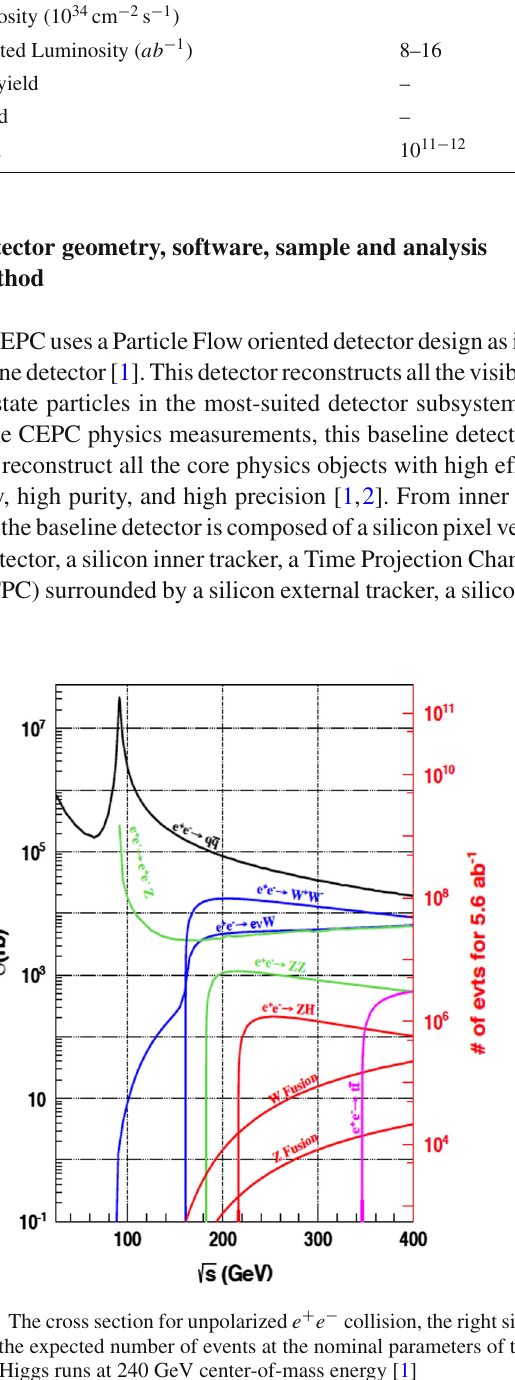
Table1 Runningtime,instantaneousandintegratedluminositiesatdif- ferent values of the center-of-mass energy and anticipated correspond- ing boson yields at the CEPC. The Z boson yields of the Higgs factory and WW threshold scan operation are from the initial-state radiative